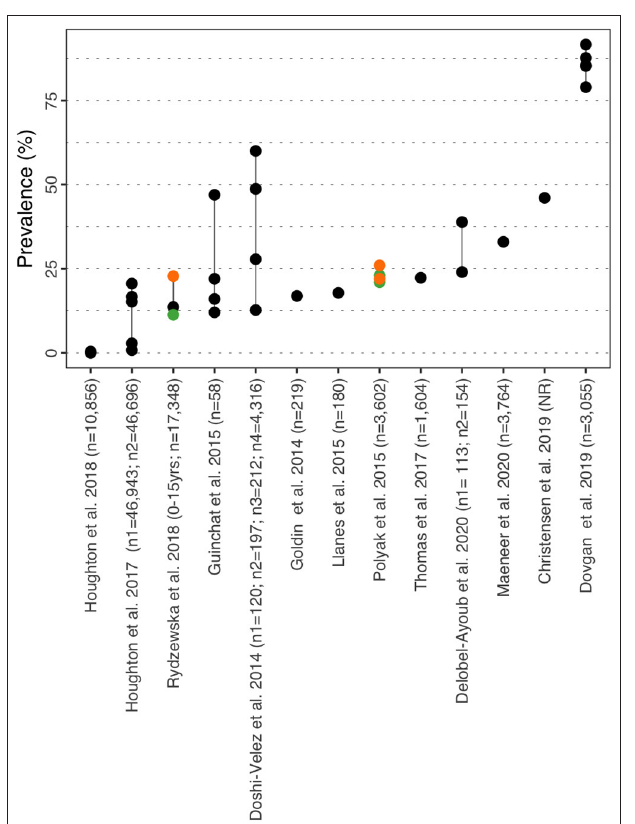
FIGURE 9 | Intellectual disability prevalence estimates. Each point reports a prevalence estimate for the related comorbidity. Studies with more than one data point indicate the estimate of the prevalence among different subgroup of the population. See Supplementary Table 4 for the description of the population used in each study. Sample sizes are shown in brackets above each study label. Orange mark: Female population only; Green mark: Male population only; Black mark: No sex distinction.